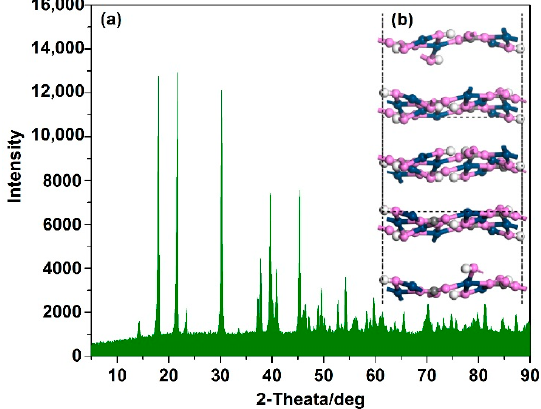
Figure 1. XRD pattern ( a ) and structural model ( b ) of malachite crystals [31,32].